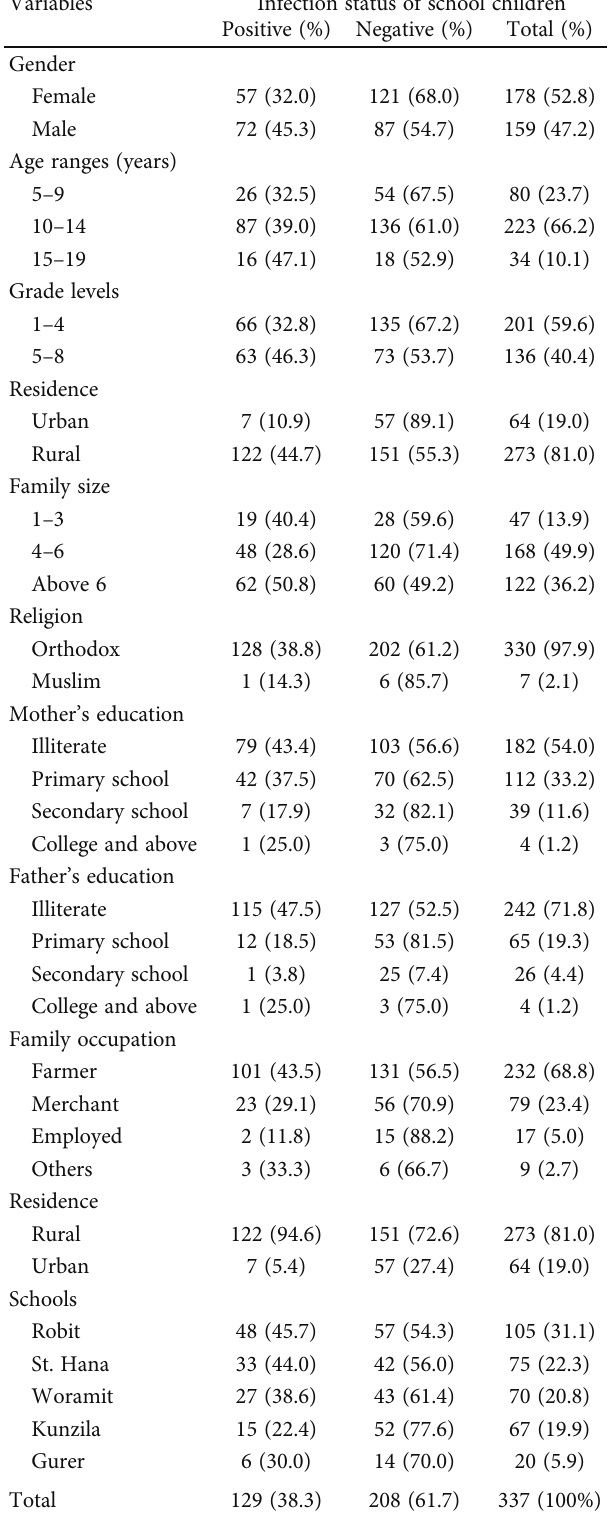
Table 2: Prevalence of soil-transmitted helminth infection across sociodemographic characteristics of the schoolchildren around Lake Tana, northwest Ethiopia, 2021.